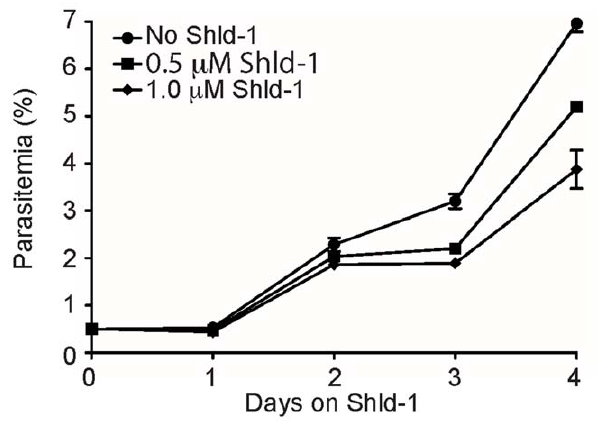
Figure 1. Effect of Shld-1 on parasite development. P. falciparum 3D7 blood stage parasites were incubated with or without the indicated concentrations of Shld-1 and the parasitemia monitored for 4 days by flow cytometry.